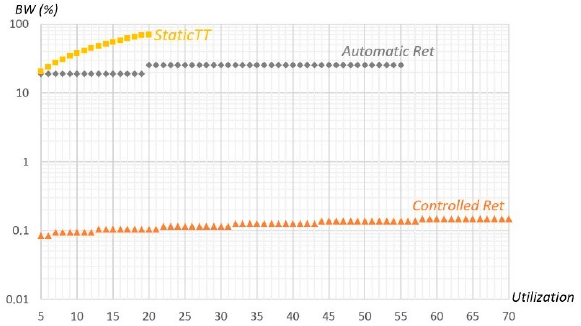
Figure 12 . Bandwidth required by each method (with LEC = 2.5 ms and λ = 0.26). Figure 12. Bandwidth required by each method (with LEC = 2.5 ms and λ =